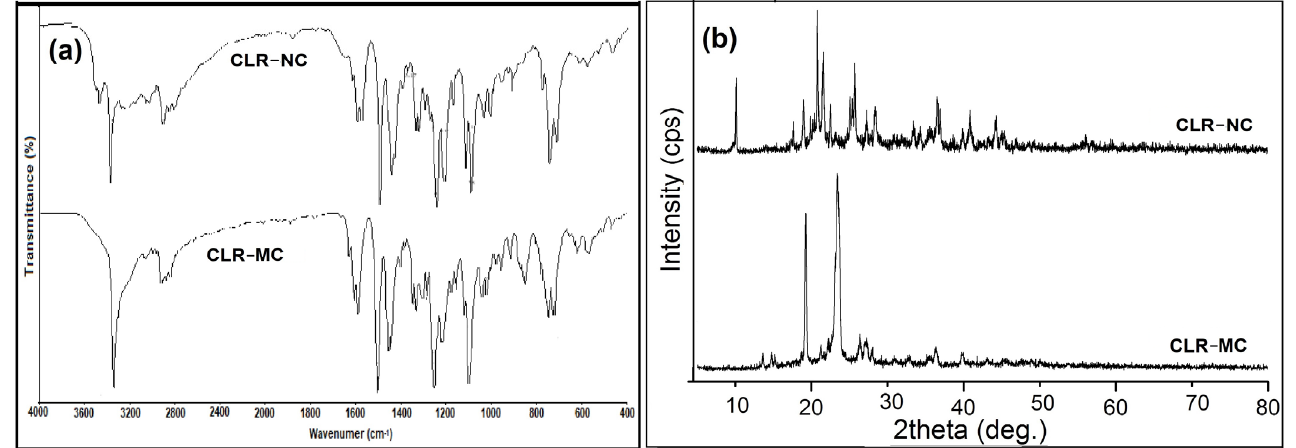
Figure 6. ( a ) FT-IR spectra and ( b ) XRD pattern of CRL-MC and -NCs